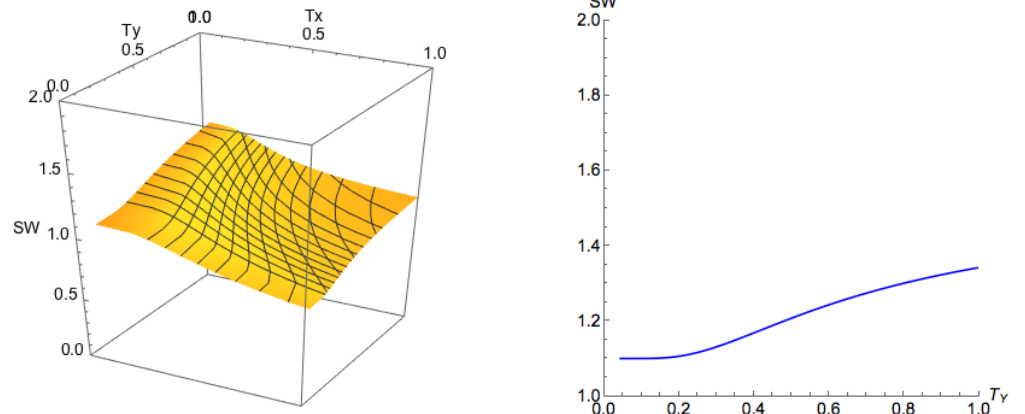
Figure 6. The left figure is the social welfare on the principal branch for Example 2, and the right figure is an illustration when T X = 0. We can see that by increasing T y , we can obtain an equilibrium with a social welfare higher than that of the best Nash equilibrium (which is T x = T y =